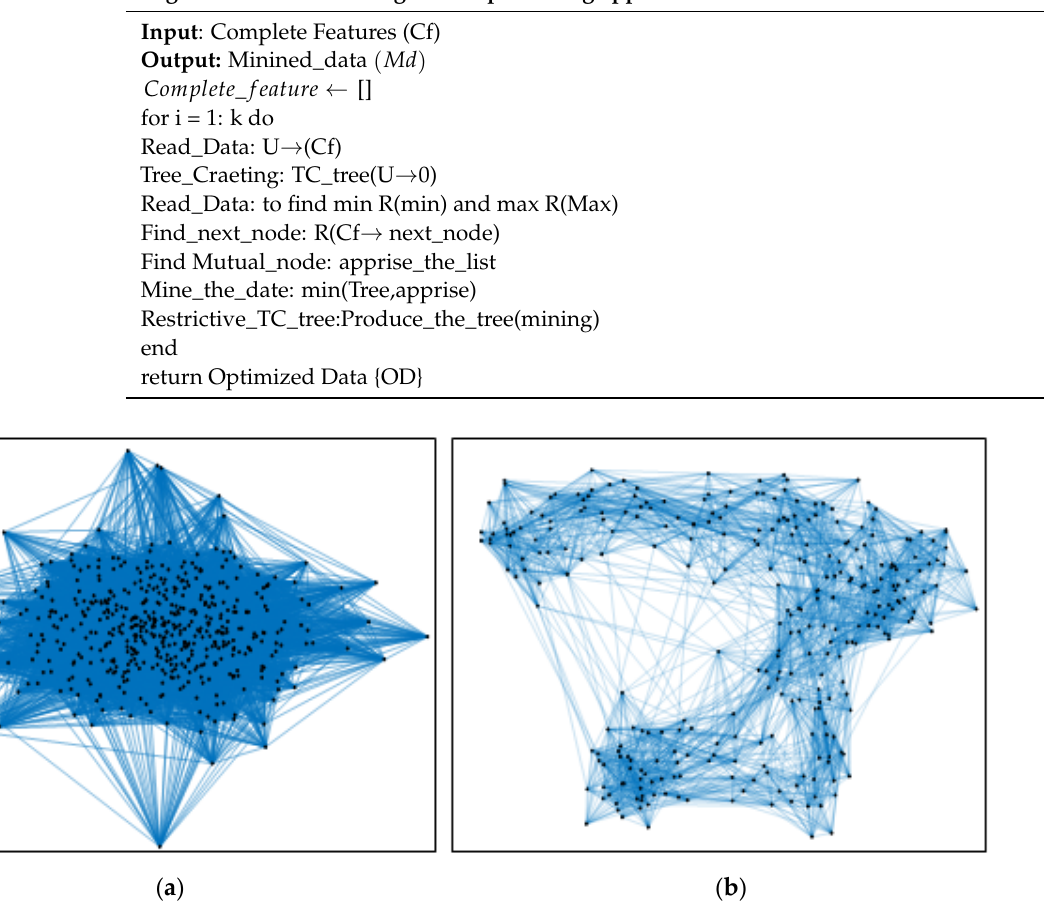
Algorithm 2: Data mining via Graph mining approach